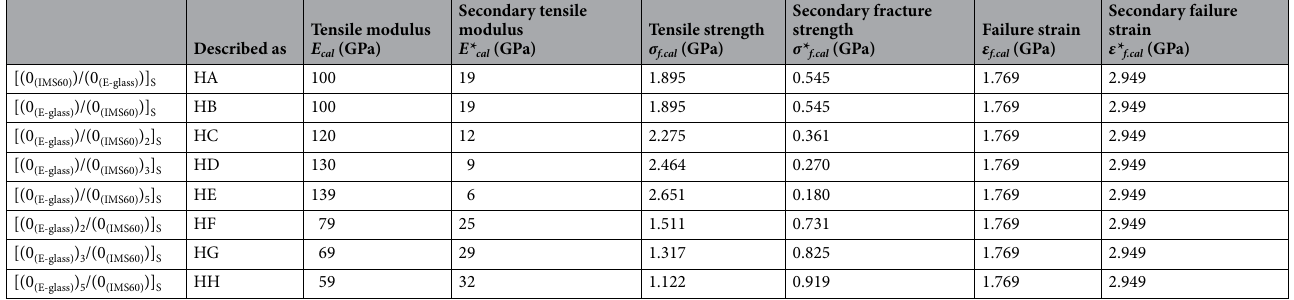
Table 3. Estimated tensile properties of the HFRP specimens.